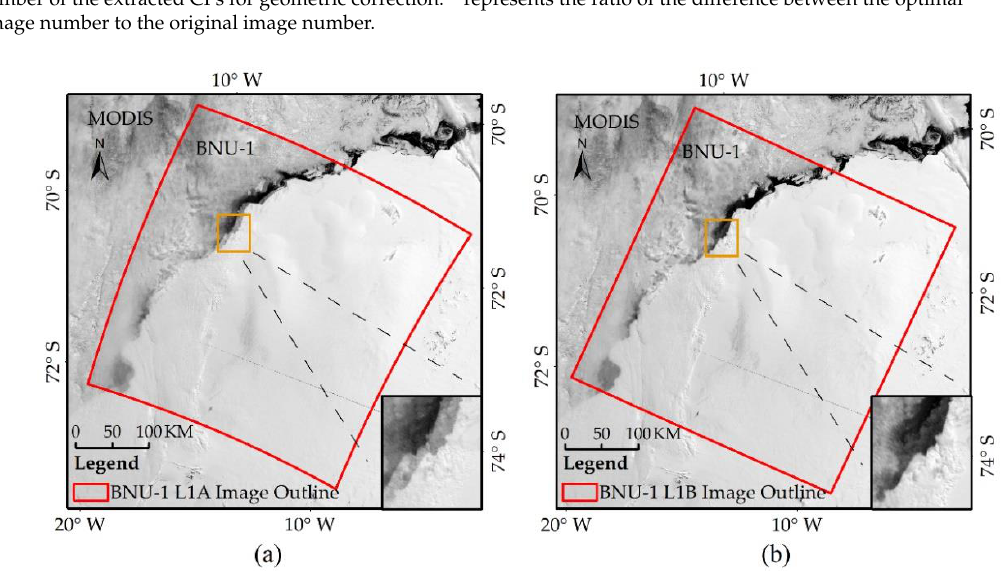
Figure 8. The BNU-1 images superimposed on the corresponding MODIS images. ( a ) BNU-1 L1A image; ( b ) BNU-1 L1B image. Red boxes refer to the extent of the BNU-1 L1A/L1B images.